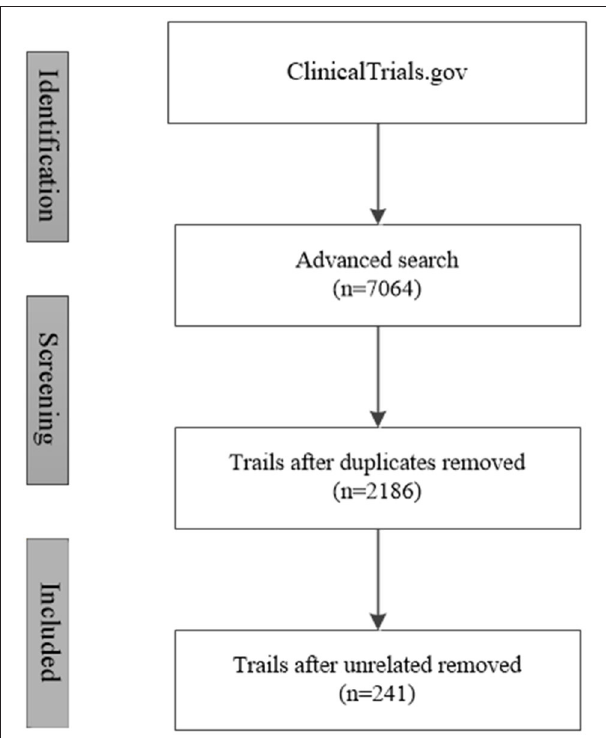
FIGURE 1 | Trial retrieval